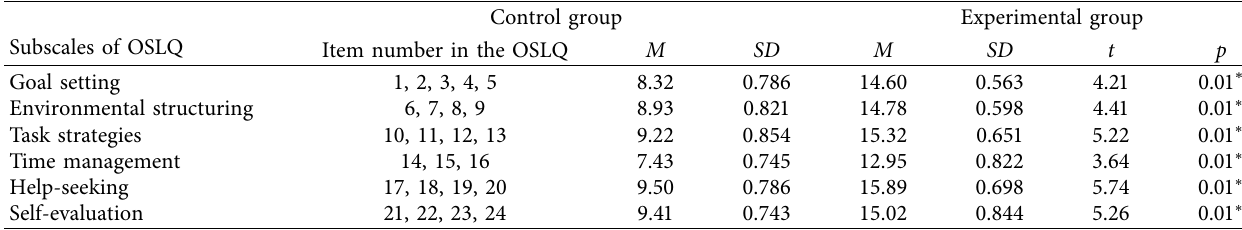
Table 7: Independent-samples t -test results for the differences in the mean scores between the control group and the experimental group on the postapplication of OSLQ in terms of its six subscales. Subscales of